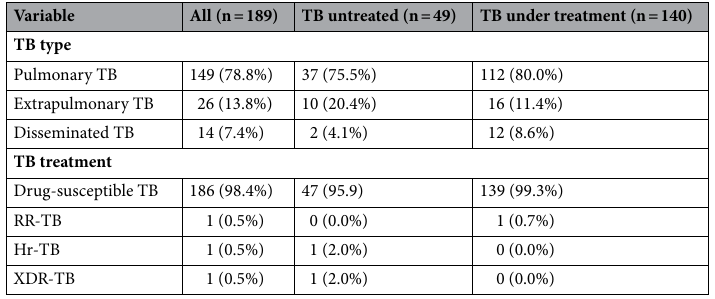
Table 2. Table describing the location and treatment of TB patients. Variable expressed as a number of subjects (n) and percentage (%). TB: tuberculosis; RR-TB: rifampicin-resistant TB; Hr-TB: isoniazid-resistant TB; XDR-TB: extensively drug-resistant TB.